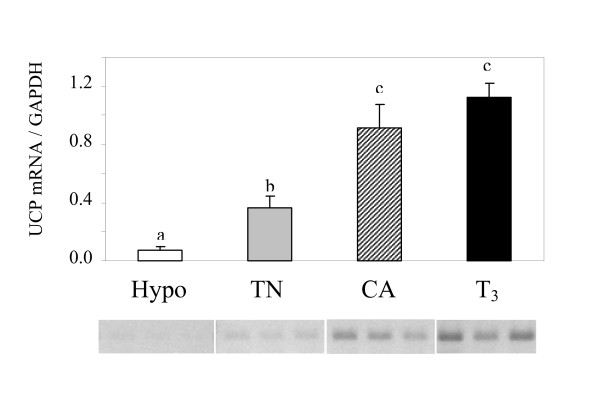
Relative abundance of UCP mRNA in red gastrocnemius muscle from thermoneutral controls (TN), cold-acclimated (CA), hypothyroid (hypo) or T3-treated (T3) ducklings. RT-PCR results of three birds per group are illustrated. Bar values are means ± S.E.M. from six birds per group. Bars with different letters are significantly different (P < 0.05).